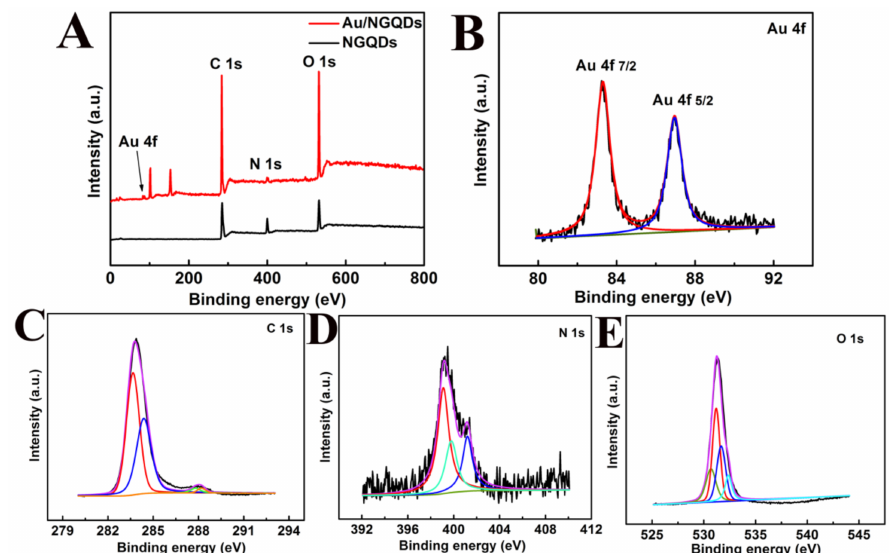
Figure 2. ( A ) XPS full scan spectra of NGQDs and gold nanoparticle (AuNP) / NGQDs. ( B – E ) The XPS analyses of Au 4f, C 1s, N 1s, and O 1s of AuNP / NGQDs,